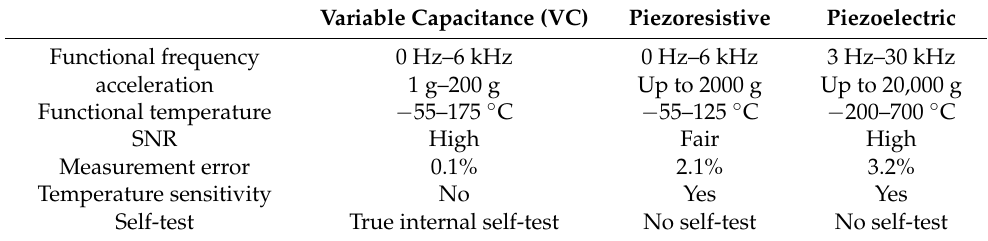
Table 1. Comparison of VC, piezoresistive and piezoelectric technologies.